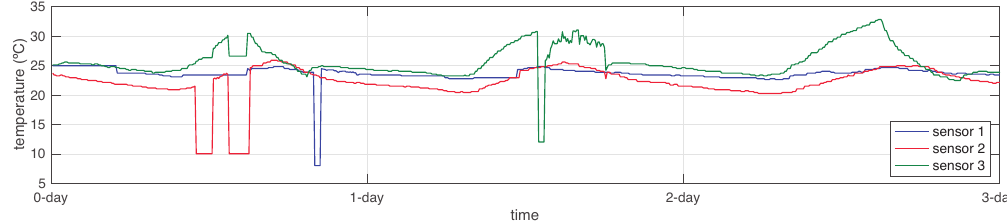
Figure 17. Sensor accommodation and final results over the WSN using the proposed SFDIA